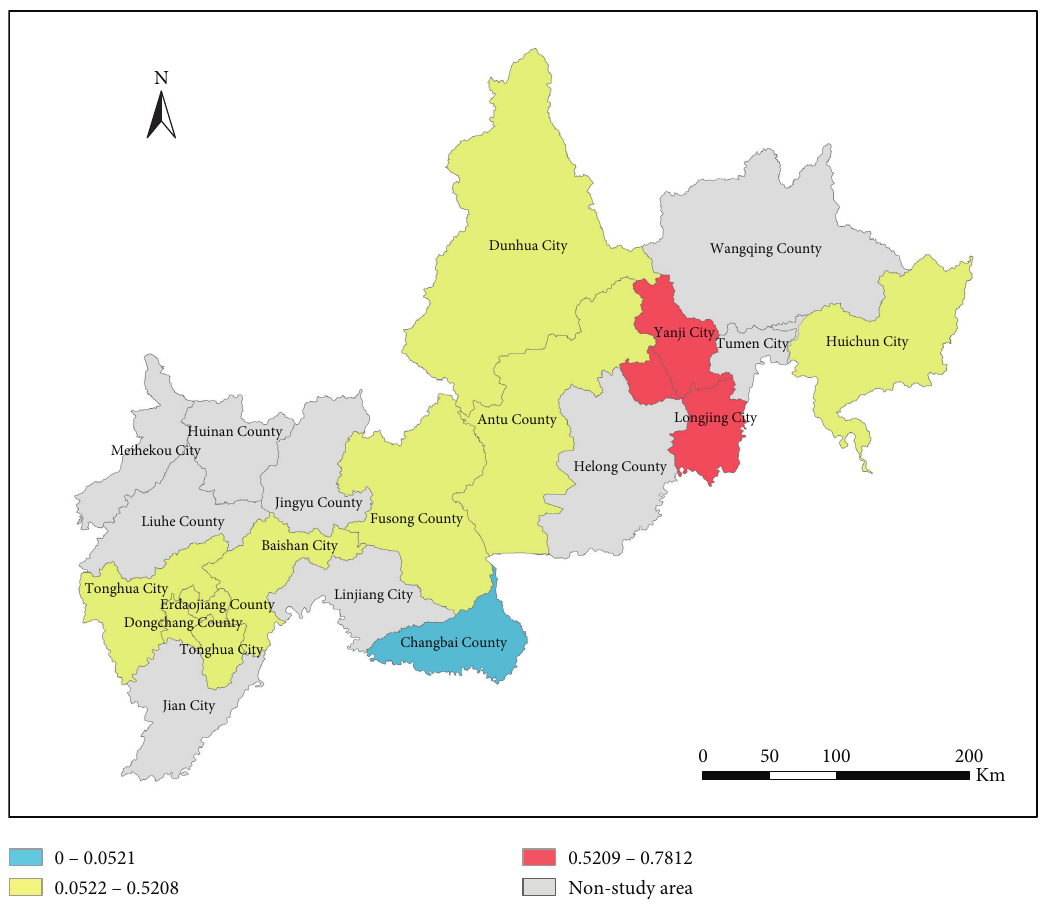
Figure 2: Clustering results on the cities in the core region of CGM tourist